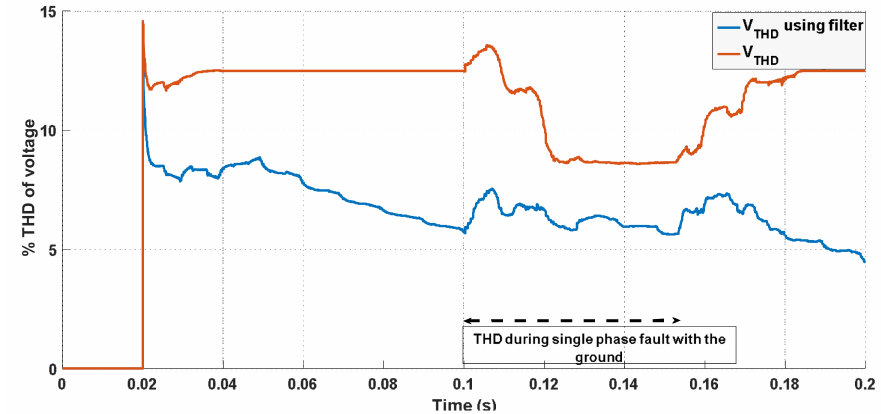
Figure 19. Comparison of the %THD of voltage calculation with and without THD